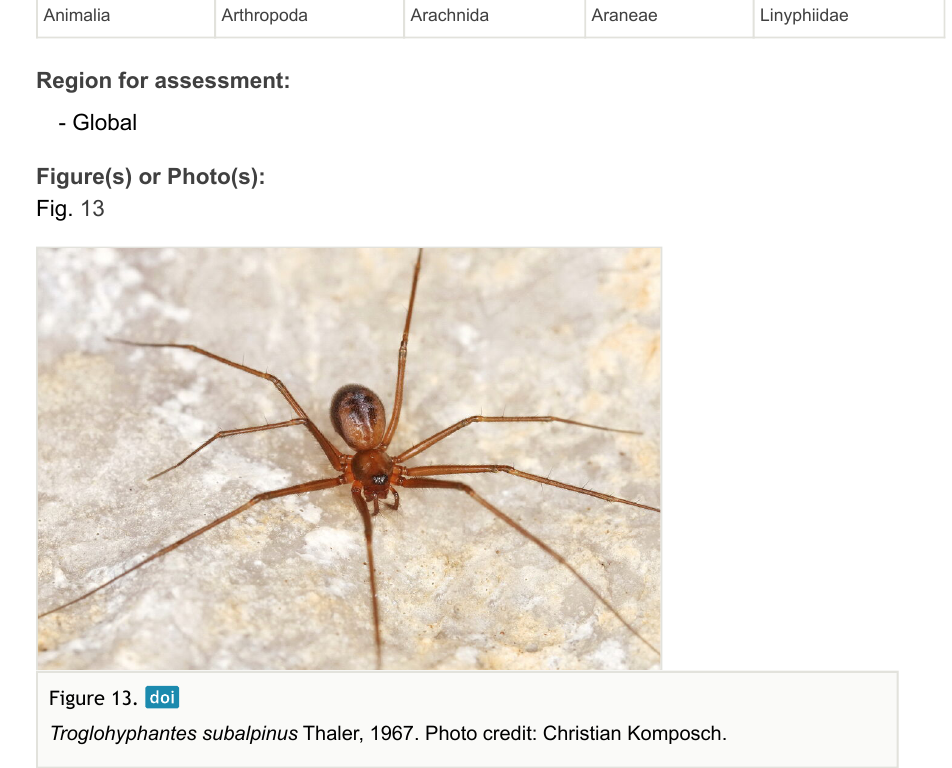
Troglohyphantes subalpinus Thaler, 1967. Photo credit: Christian